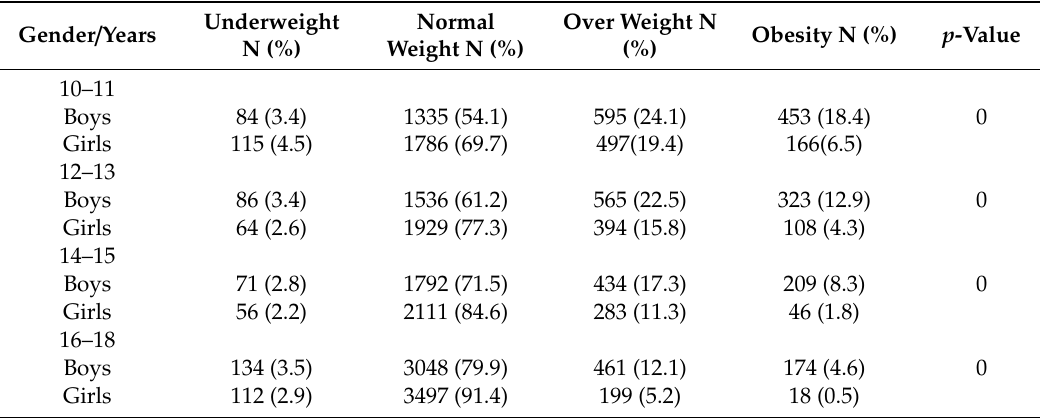
Table 1. Prevalence of underweight, normal weight, overweight, and obesity.